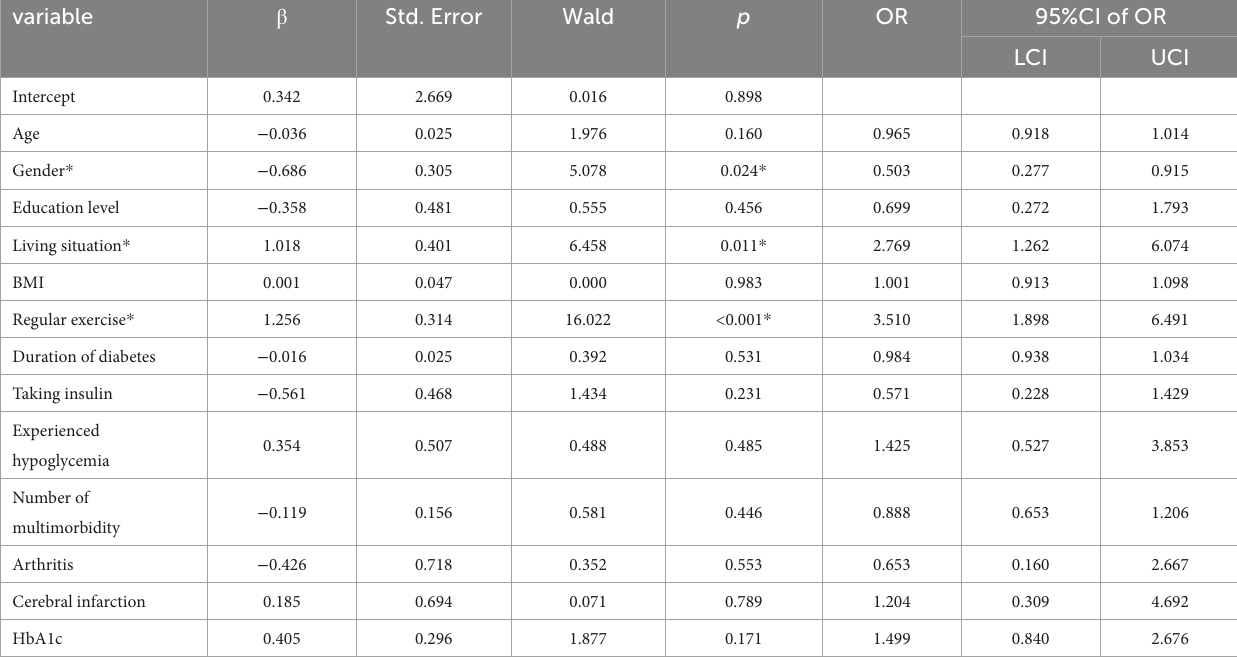
TABLE 6 Multinomial logistic regression analysis of predictors in cluster group membership (“intermediate” vs. “good”).